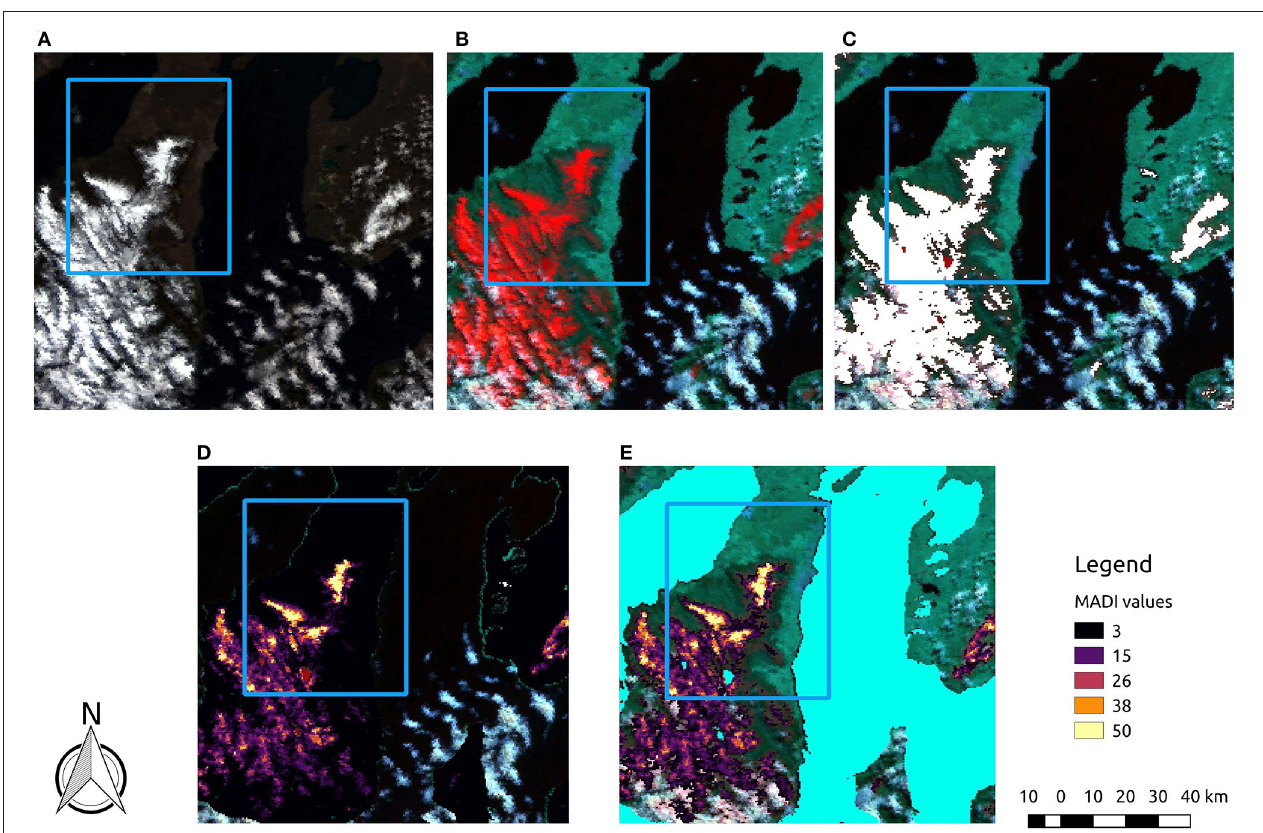
FIGURE 2 | MODIS-derived snow cover for the 26th of August 2015. (A) True color composition (1-4-3 MODIS bands), snow and clouds are both represented in white color. (B) False-color composite (MODIS bands 3-6-7) with snow in red and clouds in white. (C) NDSI mask, snow in white color. (D) MADI index, purple to light yellow colors show smaller to larger values, and clouds in white color. (E) Overlay of MADI values over the false color composite on snow covered areas as inferred from the NDSI mask, and the water mask in cyan. The macro zone limits are shown as a blue